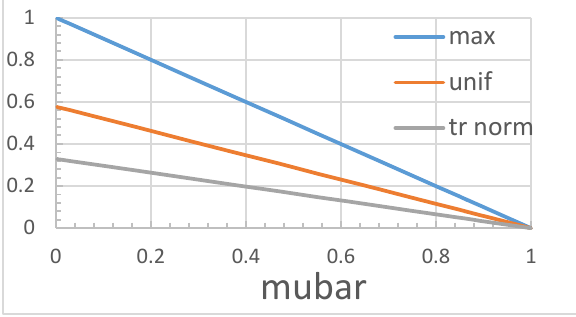
uniform distribution If the value of mubar is not 0.0, then the limits of the uniform distribution are linearly scaled to a symmetric (i.e., about mubar) sub-interval that preserves mubar. For example, if mubar = 0.2, the uniform limits are -0.6 and 1.0. These results are illustrated in Figure 3. Consistent with Figure 1, the standard deviation of the uniform distribution with mubar = 0.2 is smaller (0.46188) than the mubar = 0.0 distribution (0.57735). These values come from the formula for the standard deviation of uniform distributions.